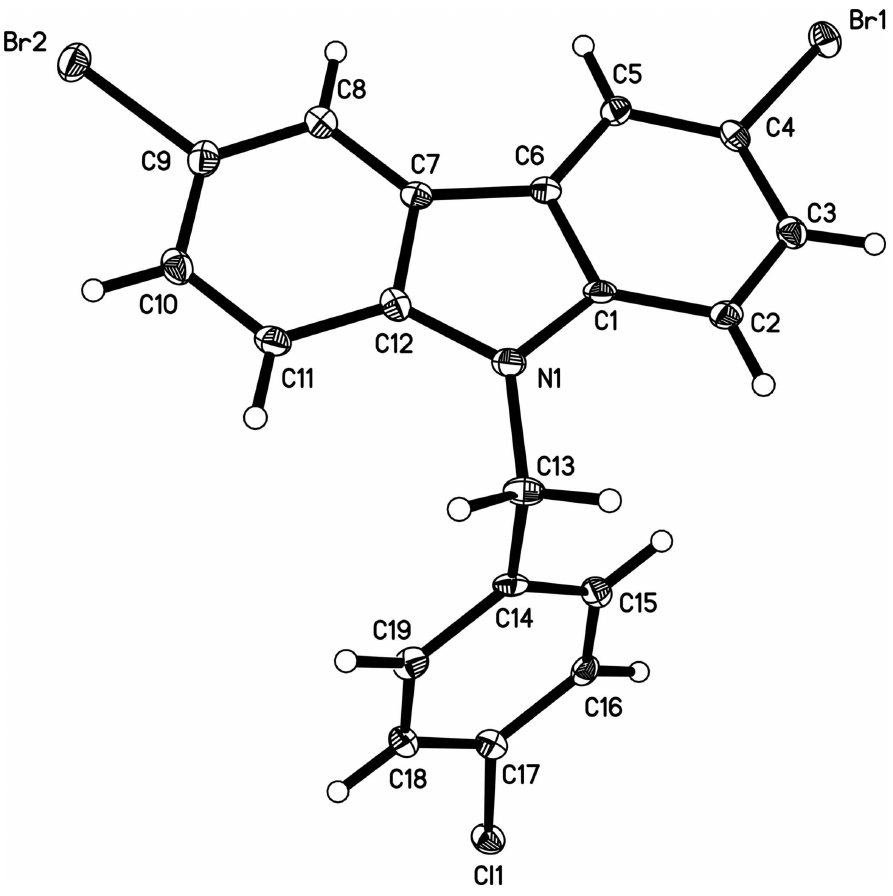
Figure 1 A perspective view of (I) with displacement ellipsoids drawn at the 30% probability level.